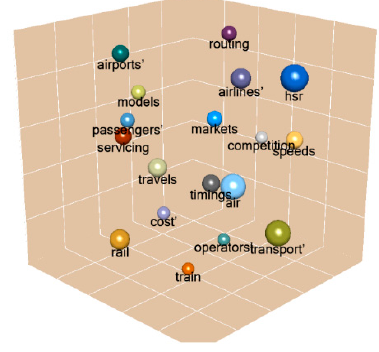
Figure 1. Cluster Analysis of the Word